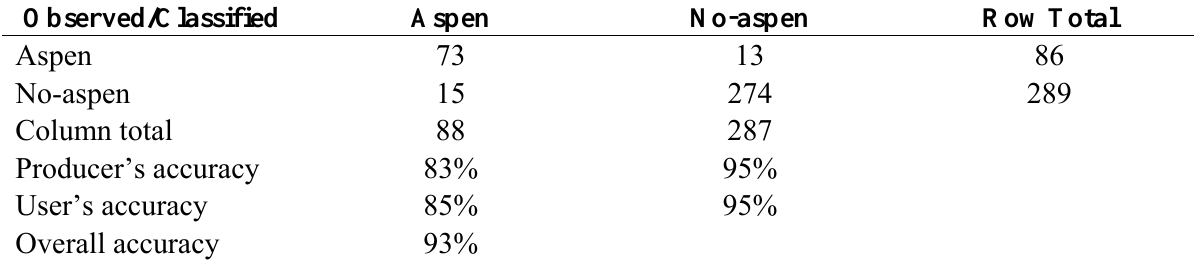
Table 1. 1987 Landsat image classification accuracy assessment.